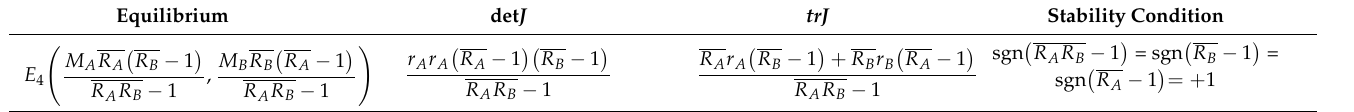
Table 3. Stability analysis of coexistence equilibrium in the competition symbiosis.